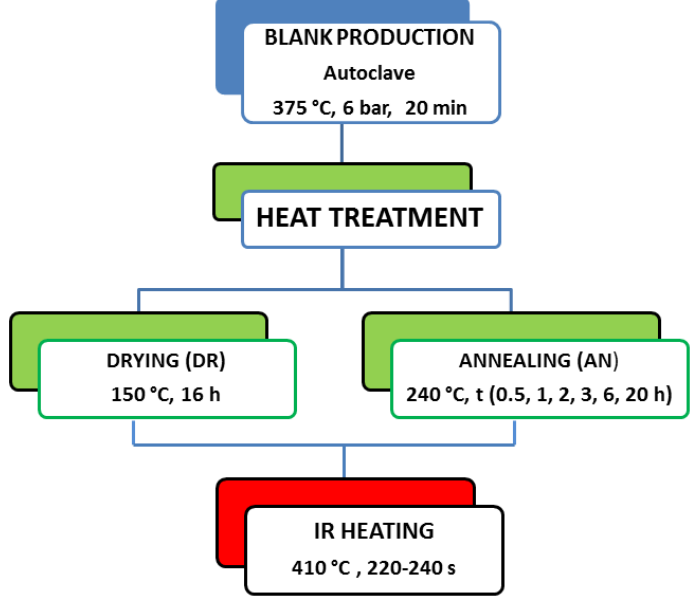
Figure 3. Schematic overview of the heat treatments performed on blank laminates.